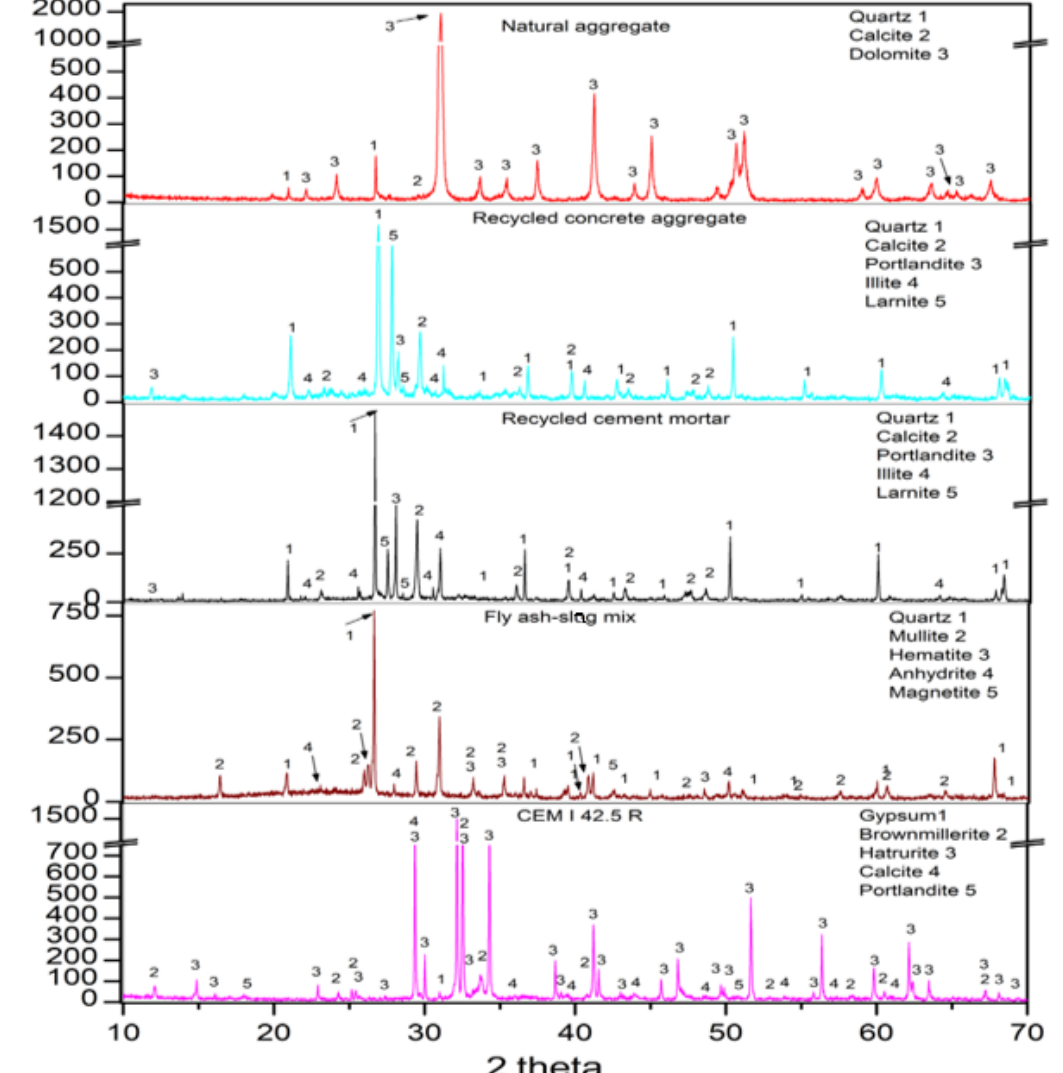
Figure 5. X-ray diffraction patterns of the raw materials. For recycled concrete aggregate, the phases found were quartz (05-0490), calcite (05-0586), portlandite (44-1481), illite (02-0050), and larnite (09-0351) [56]. The same phases were found by Suescum-Morales et al. [1] for recycled masonry aggregate. For recycled cement mortar, the same phases were found as for recycled concrete aggregate. This result is logical, as they are the same material, only sieved. The fly ash–slag mix was observed to be an amorphous compound. The main phases were quartz (05-0490) and mullite (15-0776). Magnetite (19-0629), hematite (33-0664), and anhydrite (37-1496) were also found. In addition, the phases detected for the cement were hatrurite (86-0402), brownmillerite (11-0124), calcite (05-0586), gypsum (21-0816), and portlandite (44-1481) [56], which